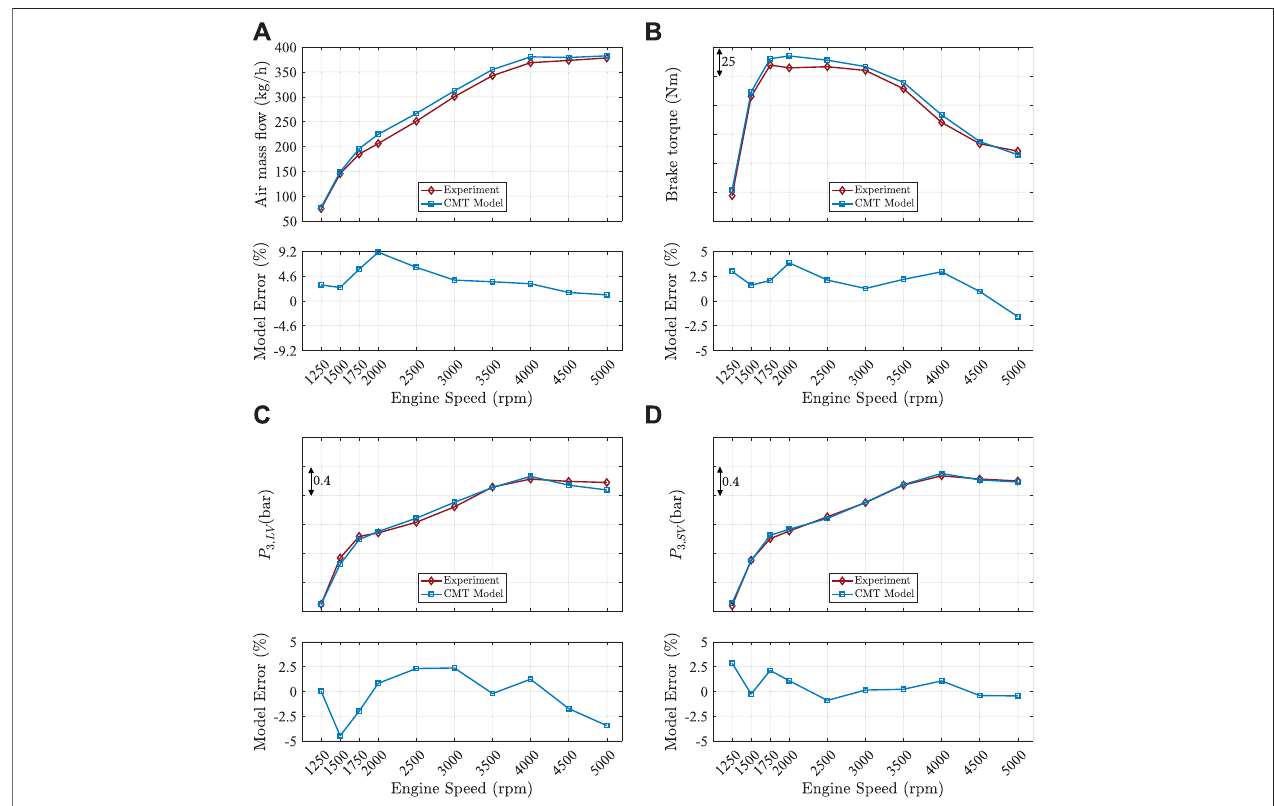
FIGURE 14 | Validation parameters of SCV opened simulation. Outputs from the CMT-DETCM model compared against the experimental data at different engine speeds. (A) Air mass fl ow; (B) brake torque; (C) turbine inlet pressure in LV; (D) turbine inlet pressure in SV.